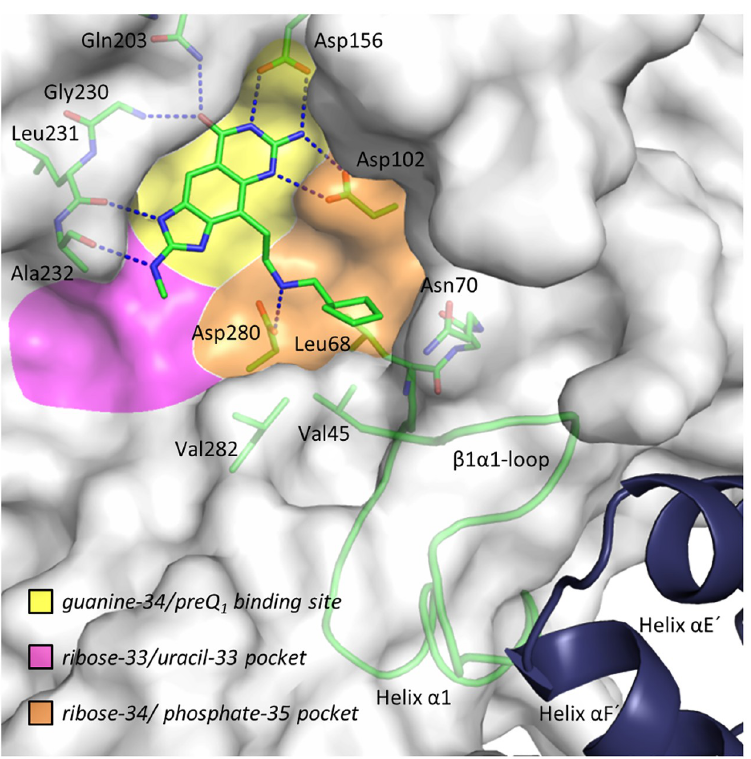
Fig 1. Overviewof the active site, its different sub-pockets (yellow, orange, magenta), and part of the second monomer. Co-crystal structure of TGT with inhibitor 5 (TGT (cid:1) 5 co ). The protein is shown as transparent solvent accessiblesurface and the loop-helixmotif as cartoon. Color code: C green, O red, N blue. 5 and selectedresidues are displayedas sticks. For the sake of clarity, residues Tyr106 to Leu111are not shown. Val45, Leu68 and Val282form the hydrophobicfloor of the ribose-34/phosphate-35 pocket (orange).Selectedportions of the second monomerof the homodimer are shown as blue cartoon. Blue dashedlines indicateH-bondsfrom 5 with the protein (2.7–2.9 Å ). These characteristics apply to all following figures unless otherwisestated. N 5 of the lin -benzoguaninescaffold was shown to be protonatedupon bindingto TGT allowingAsp102to form two H-bondsto the